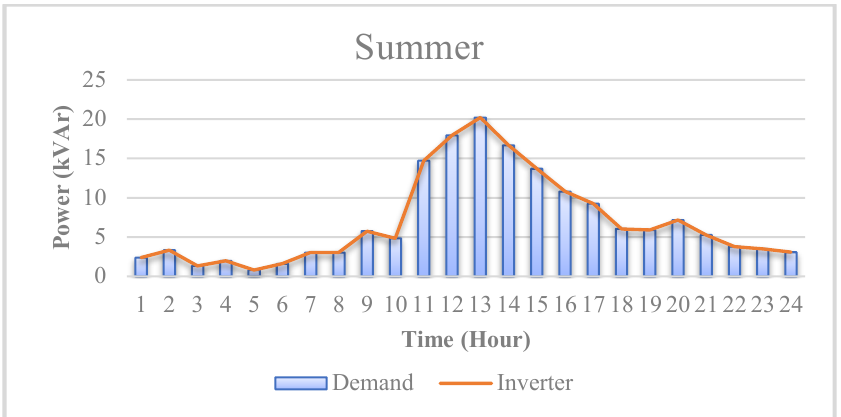
Figure 11. The reactive power support by smart inverters in summer.